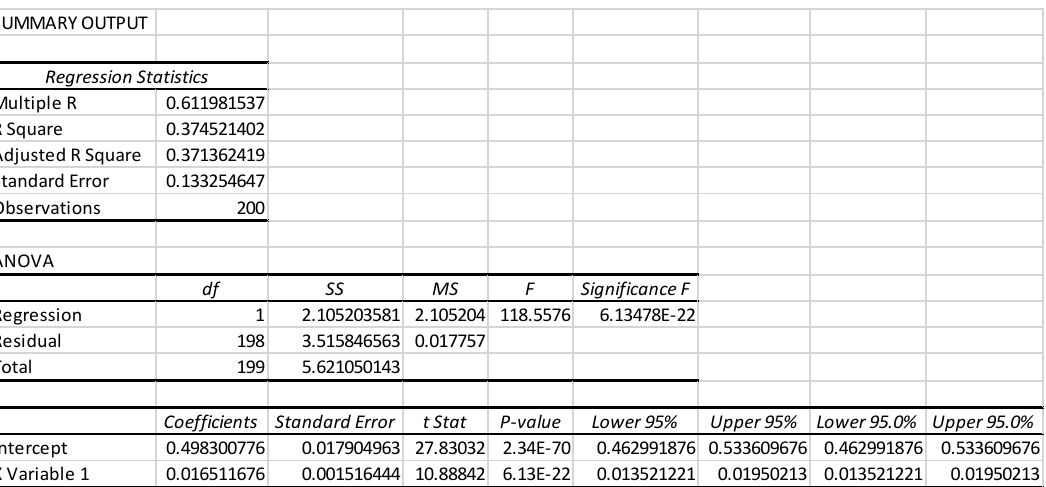
Regression Output for Independent Variable MTL1A and Dependent Variable FE (%) for Sample Size N=200 and Confidence Level of 95%